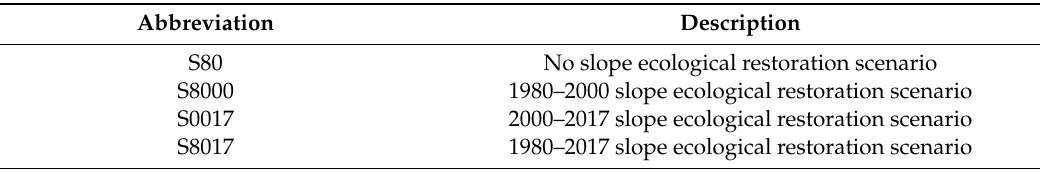
Table 7. Description of Abbreviations.